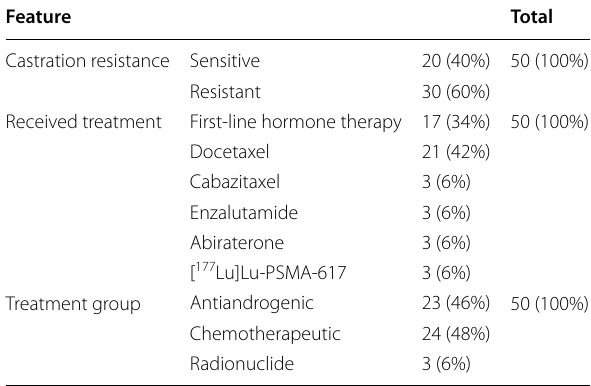
Table 2 Features of the patients before the second [ 68 Ga] Ga-PSMA-11 PET/CT images Feature Castration resistance